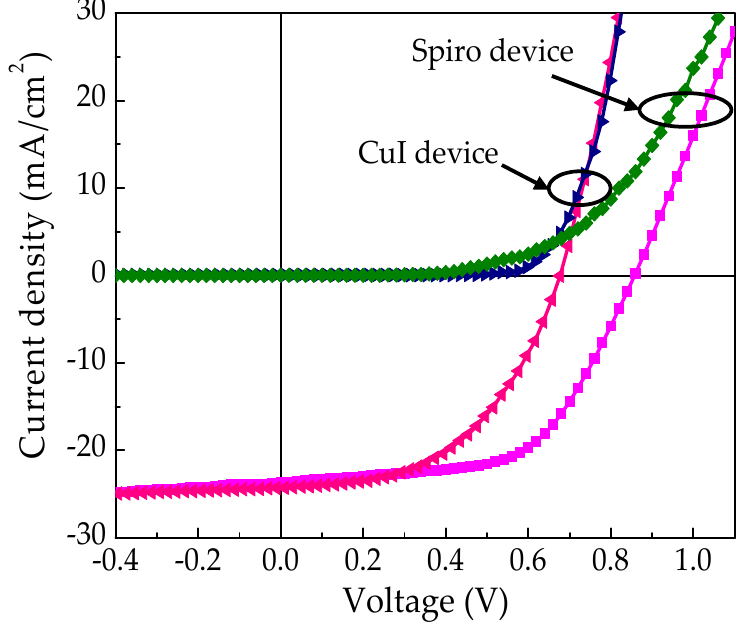
Figure 3. J-V characteristic of champion FTO/TiO 2 /MAPbI x Cl 3 − x /CuI/Pt and FTO/TiO 2 /MAPbI x Cl 3 − x /spiro-OMeTAD/Au devices under illuminations of 100 mW/cm 2 (1 sun) with air mass (AM) 1.5 filter and in dark. Table 1. The variation of photovoltaic parameters for the different HTM devices under illuminations of 100 mW/cm 2 (1 sun) with air mass (AM) 1.5 filter. (The values in bold text are from the champion cell).